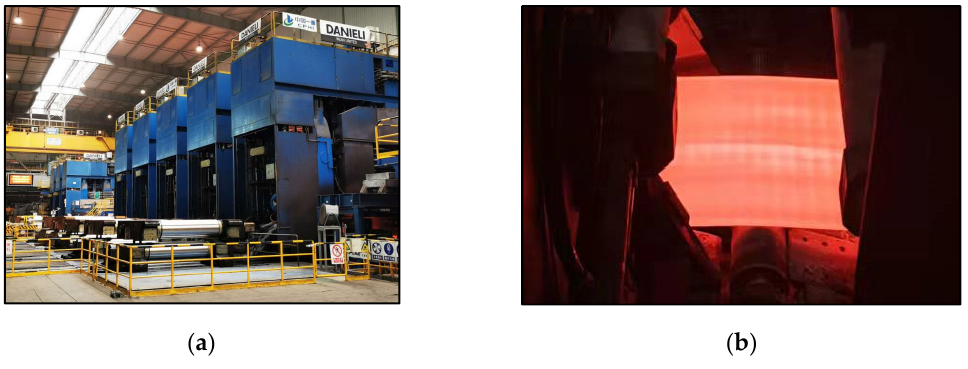
Figure 1. Tandem mill: ( a ) MCCR finishing mills; ( b ) Strip vibration chart .